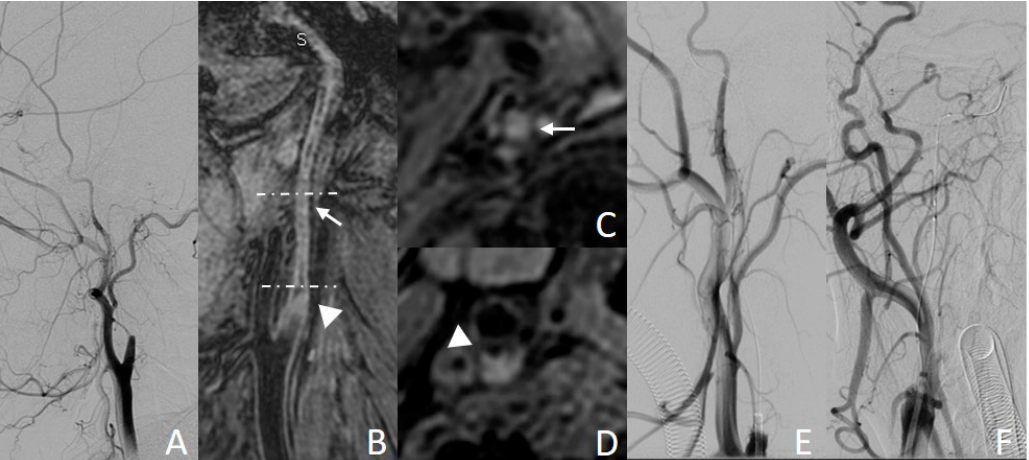
Figure 4. Example case of failed endovascular recanalization. ( A , E , F ): DSA images; ( B ): MPR image of 3D MERGE; ( C , D ): axial images of 3D MERGE. Calcification ( B and D , triangle) and collapse ( B and C , arrow) can be observed on MR images.